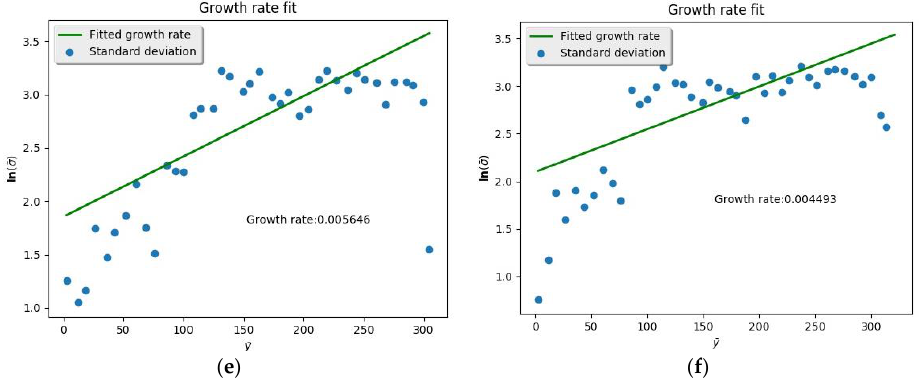
Figure 16. Spatial growth rate at different environmental pressure (all environmental pressures were over the critical point to the nitrogen and argon): ( a ) p = 6.5 MPa; ( b ) p = 7.5 MPa; ( c ) p = 8.5 MPa; ( d ) p = 9.5 MPa; ( e ) p = 10.5 MPa; ( f ) p = 11.5 MPa. Molecules 2018 , 23 , x FOR PEER REVIEW